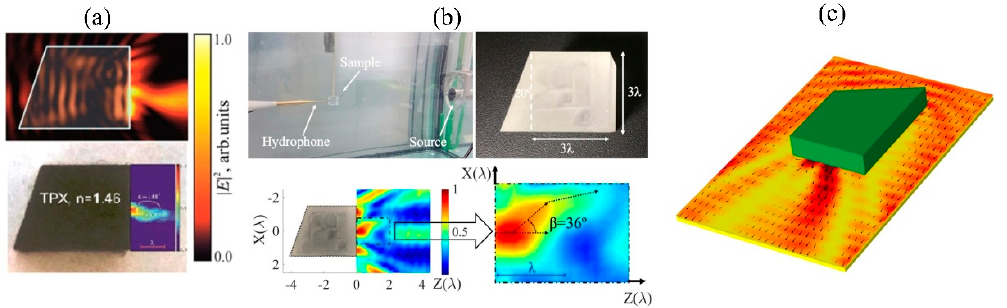
Figure 3. Photonic hook based on Janus particle: ( a ) THz [44], ( b ) acoustic [45] and ( c ) plasmonic [46].